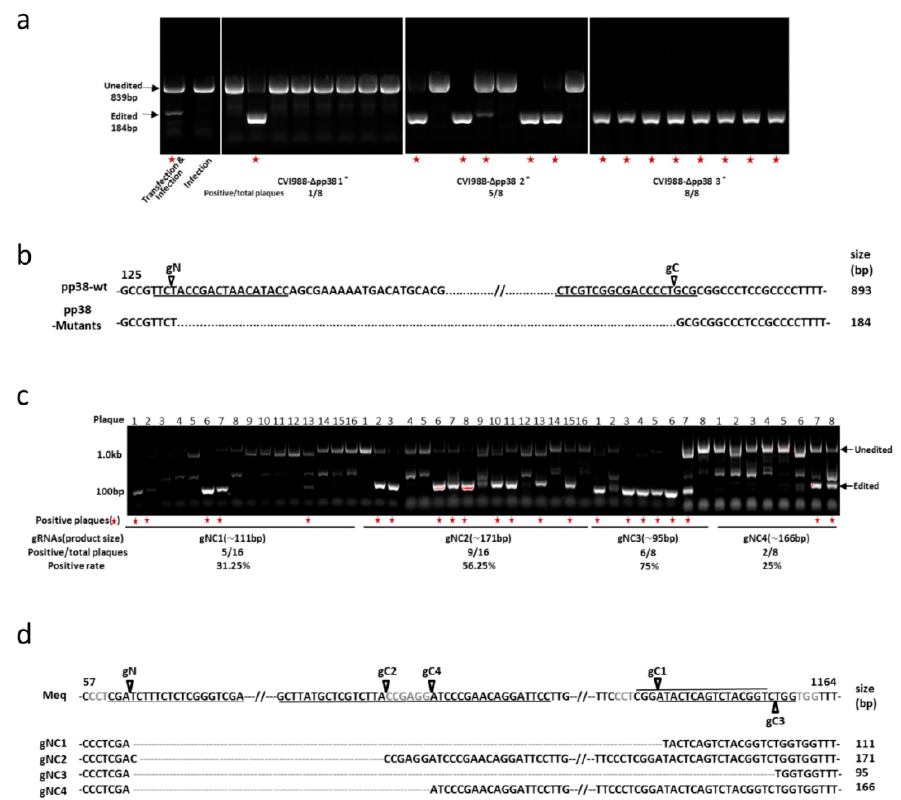
Figure 2. Isolation and characterization of mutant viruses. ( a ) PCR amplification of the edited region, using primers pp38-N-F and pp38-C-R on the cell lysate of transfected/infected cells and plaques after a subsequent three rounds of plaque purification. Red asterisk indicates the plaques containing the edited band. ( b ) The nucleic acid sequences of the truncated/edited PCR product showing the successful deletion of pp38 . Target sequence is underlined and the cleavage site is indicated by an arrow. ( c ) PCR amplification of the edited region of the Meq gene using primers Meq-N-F and Meq-C-R on the cell lysate of plaques with different pairs of guide RNAs, targeting both ends of the Meq gene. Red asterisk indicates the plaques containing the edited band. ( d ) The nucleic acid sequences of the truncated/edited PCR product showing the successful deletion of Meq . Target sequence is underlined, PAM sequence is in grey and the cleavage site is indicated by an arrow.